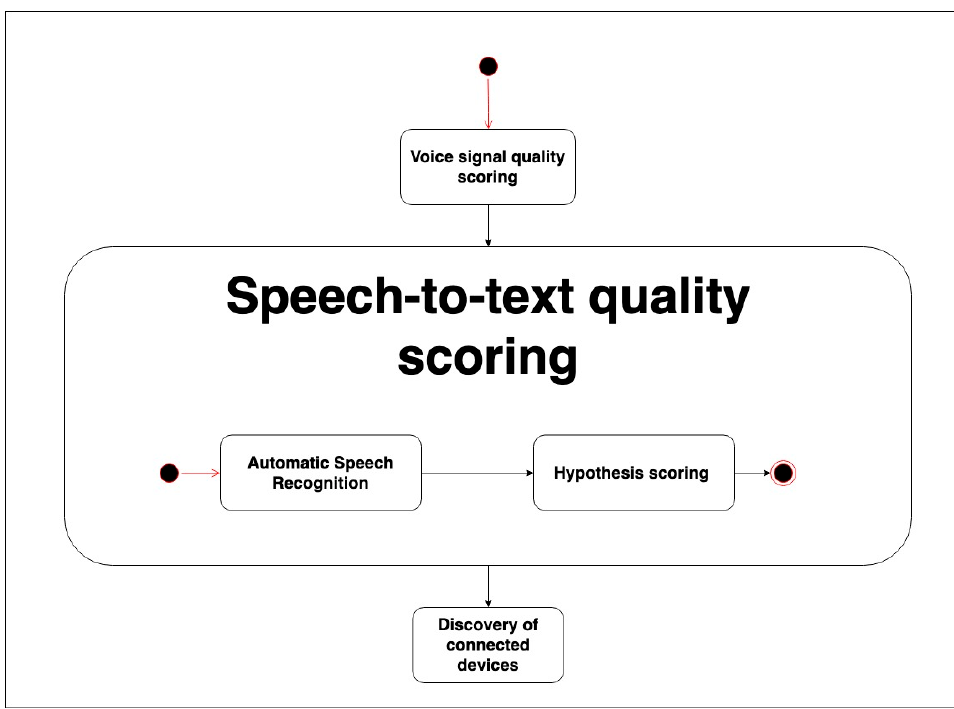
Figure 2. Detailed scheme of speech-to-text quality scoring